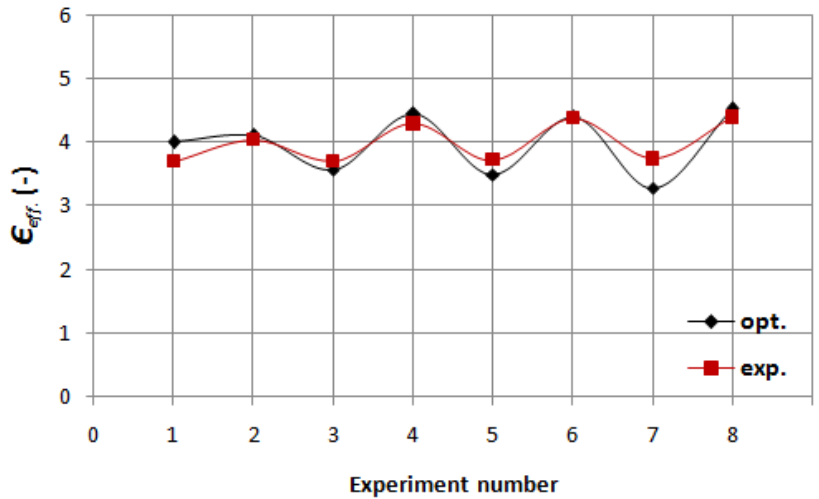
Figure 21. Comparison of DE optimal and experimental values for effective strain.